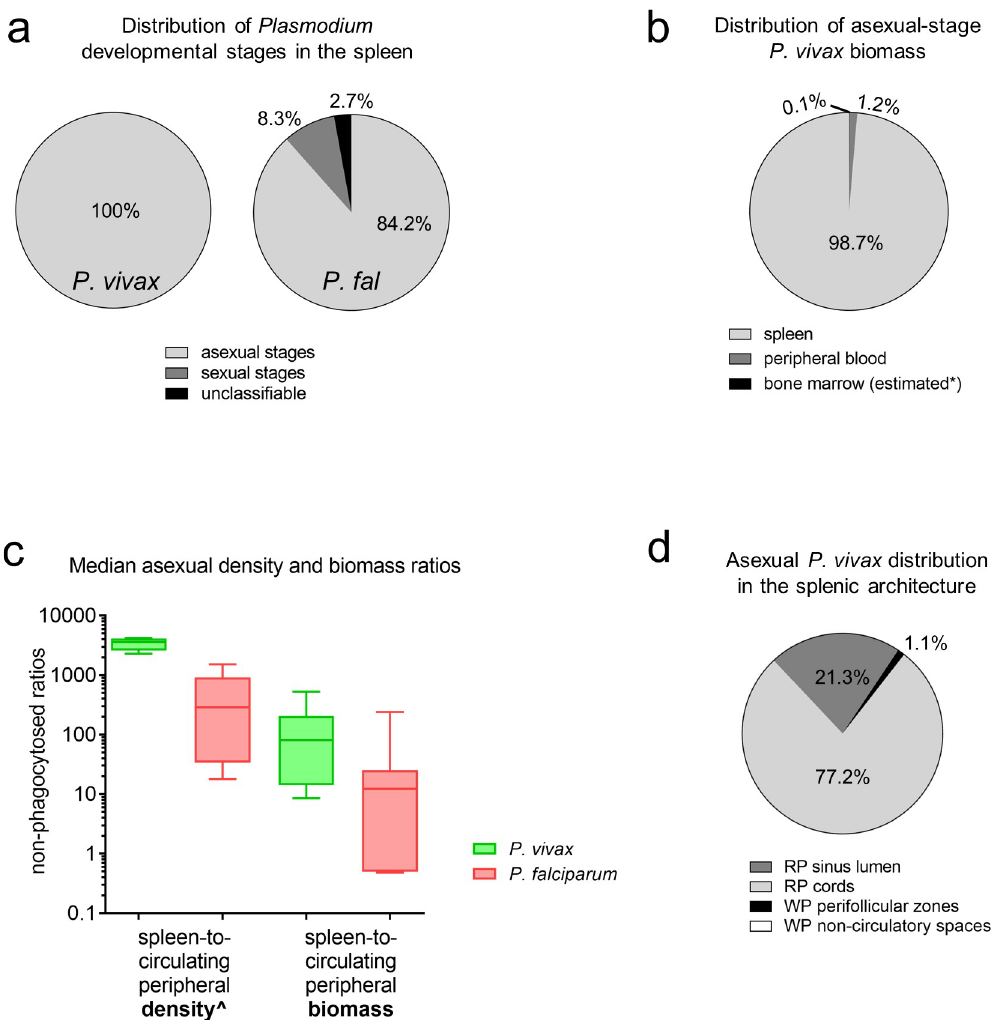
Fig 3. Splenic accumulation and distribution of non-phagocytosed IEs in cohort patients. Non-phagocytosed parasites in peripheral blood and spleen sections were counted by microscopy using an Olympus CX31 microscope. Stages were categorised into asexual, sexual, and unclassifiable for Pv ( n = 6) and Pf ( n = 9). In Pv and Pf, all individuals had asexual stages present. Sexual stages were reported in 1 Pv- and 6 Pf-infected individuals, and unclassifiable stages reported in 2 Pv- and 6 Pf-infected individuals, with the median distributions summarised as shown (a). As an additional comparator to the spleen, Pv biomass in the bone marrow was conservatively estimated based on a previous human study comparing relative Pv parasitaemia in the bone marrow to peripheral blood [20] ( � ). The median percentage of non-phagocytosed asexual Pv biomass found in the spleen, peripheral blood, and bone marrow was calculated (b). The median estimated non- phagocytosed spleen-to-peripheral asexual parasite density and biomass ratios were compared between 6 Pv and 7 Pf (c) (^reported previously [29]). The median distribution of asexual Pv stages in the splenic architecture was categorised into those found in the RP cords and sinus lumens, and WP non-circulatory spaces and perifollicular zones (d). Two individuals had < 0.3% of asexual Pv in WP non-circulatory spaces. In panels a and d, the sum of segments in each pie chart may not add up to 100% due to medians in one of the groups being zero despite some individuals having values > 0%. In panel c, medians, interquartile ranges, and ranges are shown, compared using the Mann–Whitney test ( p -value < 0.05 considered significant). IE, infected erythrocyte; Pf, Plasmodium falciparum ; Pv, Plasmodium vivax ; RP, red-pulp; WP, white-pulp.